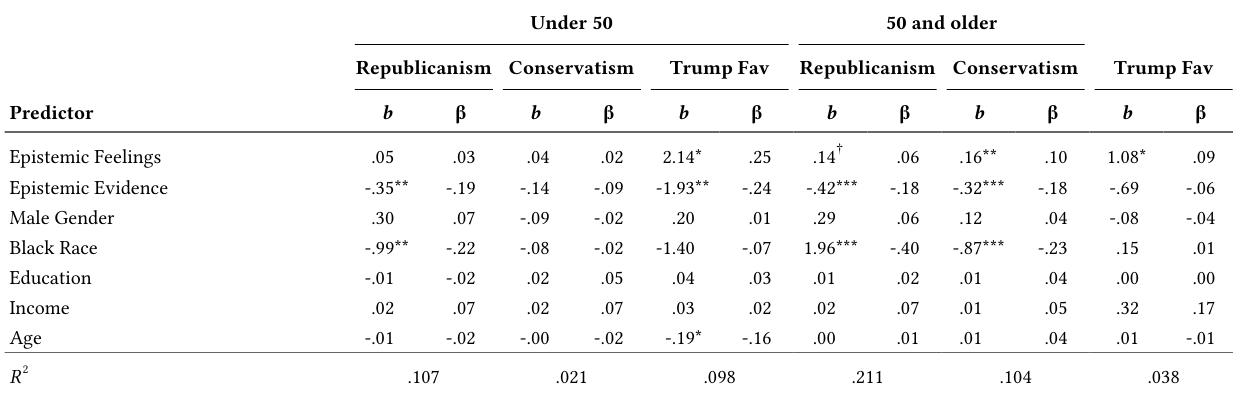
Coefficients From Regression: Republicanism, Conservatism, and Trump Favorability as a Function of Epistemic Motivations Within Each Age Sample, Controlling for Sociodemographic Characteristics